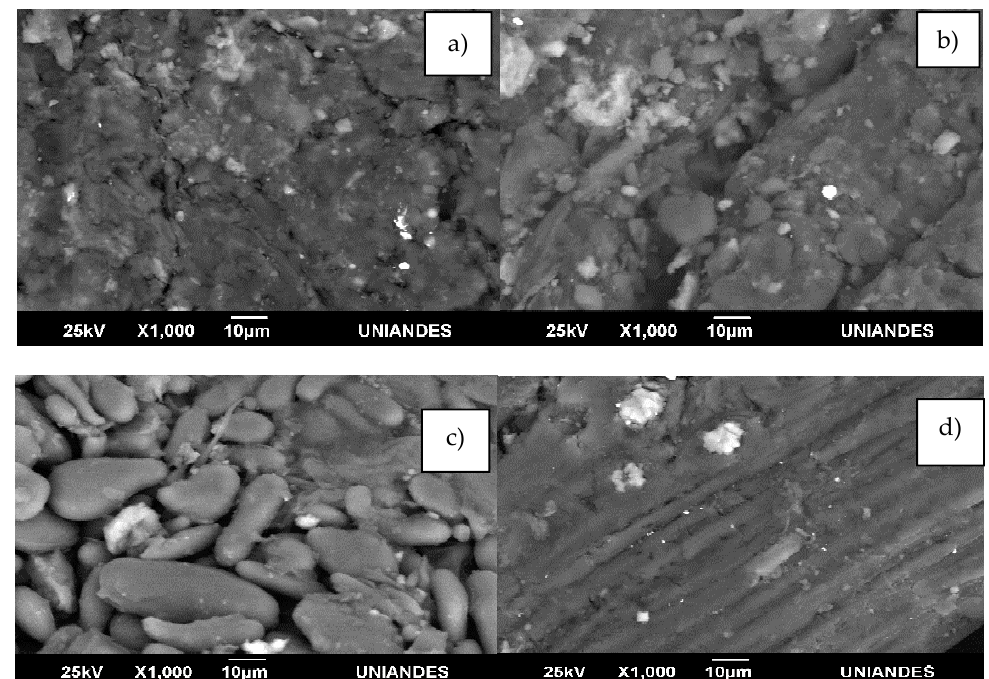
Figure 3. Micrographs from Scanning Electron Microscope before the adsorption process: ( a ) YP, ( b ) CP, ( c ) BP, and ( d ) OPB biomasses. Appl. Sci. 2019 , 9 , x FOR PEER REVIEW